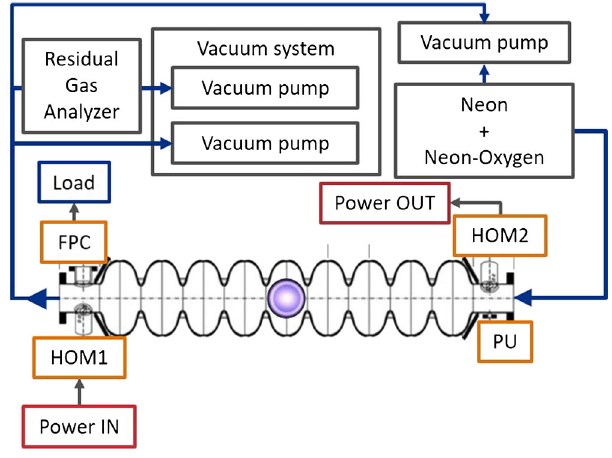
FIG. 1. Block scheme of the experimental setup used for plasma processing. The cavity is placed inside a portable clean- room, and all the connections between the cavity and the gas/ vacuum system take place inside the cleanroom.